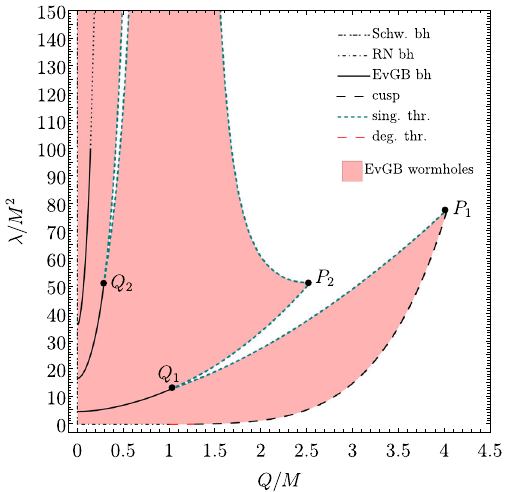
Fig. 9 Domainofexistence(DoE)inthe λ/ M 2 vs Q / M planeisshown for symmetric wormhole solutions for coupling function (i). The DoE is bounded by black holes, singular throats, degenerate throats and the emergence of cusps